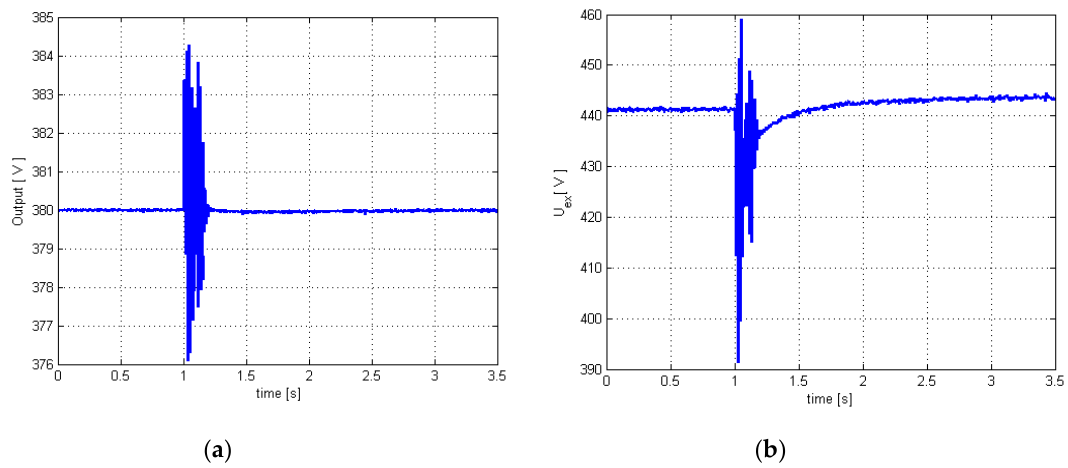
Figure 12. Resistive load—4th order model: ( a ) Terminal voltage (controlled output); ( b ) Excitation voltage (controller output).